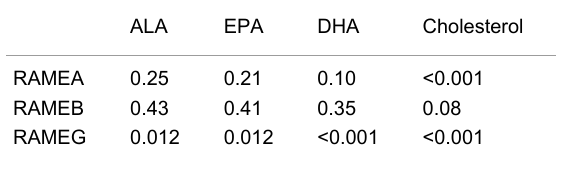
Table 1: Complexation efficiency for fatty acid and cholesterol with randomly methylated